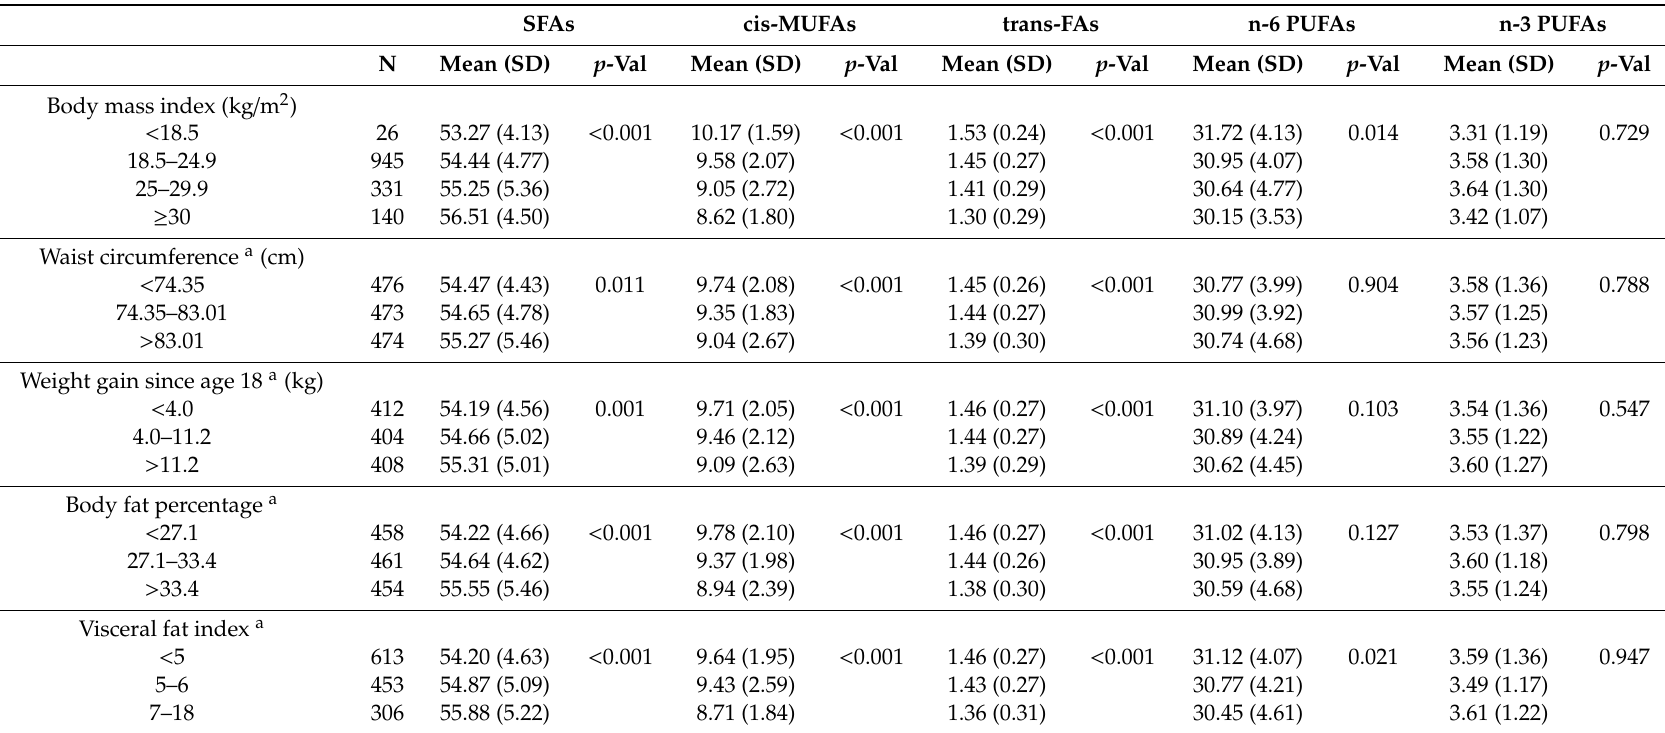
Table 2. Relative concentrations of serum phospholipid fatty acids according to anthropometric